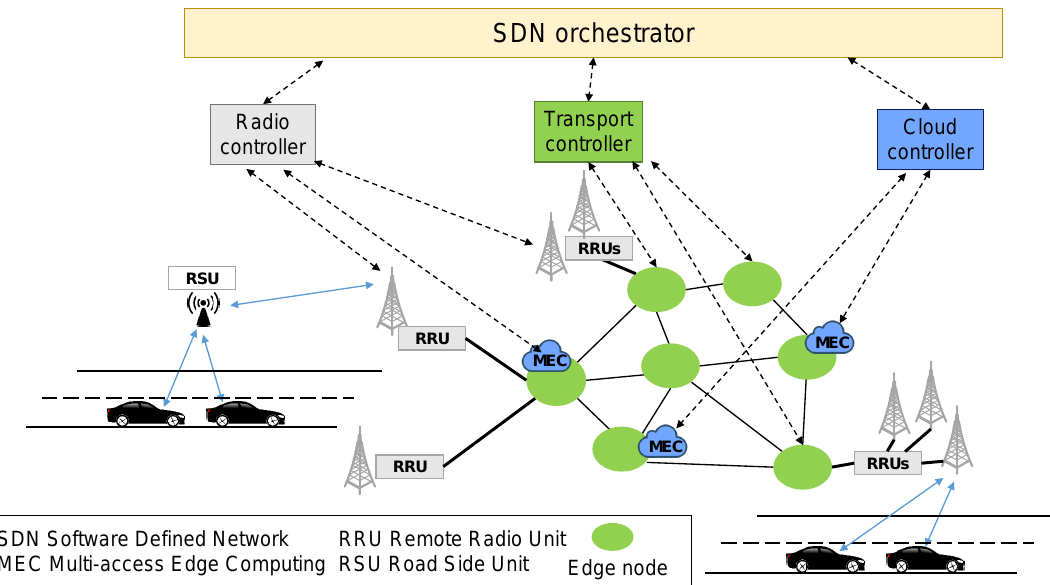
Figure 1. Softward Defined Networking (SDN)-controlled Cloud Radio Access Network (C-RAN) architecture for vehicular